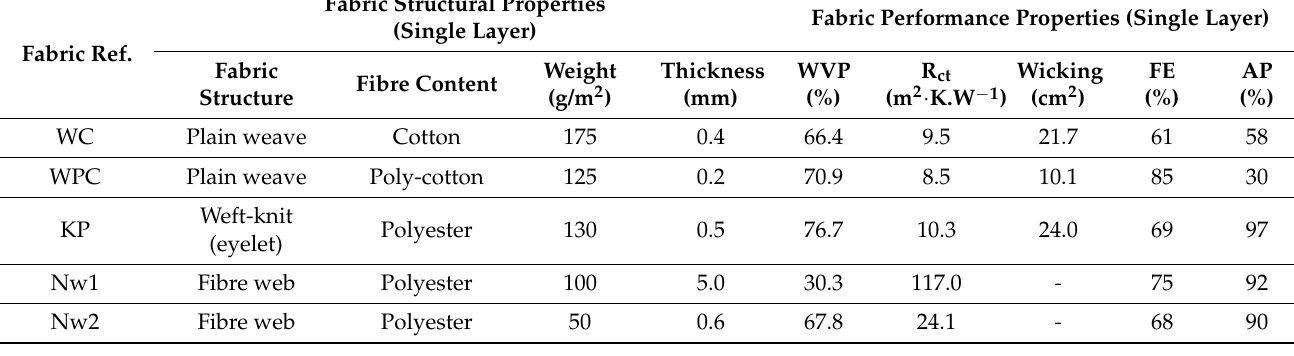
Table 2. Structural and performance properties of (single layer) fabrics and filters used in the masks described.